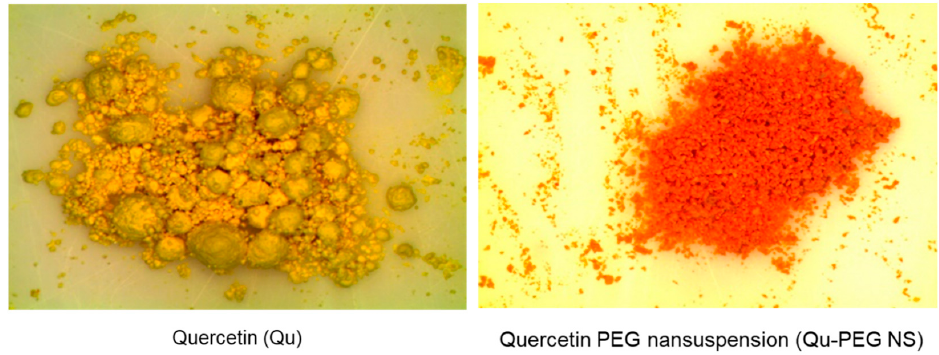
Figure 2. Stereomicroscopy photographs of quercetin (Qu) and quercetin with PEG nanosuspension 1 (Qu-PEG NS). Table 1. The composition ratio of nanosuspension formulation. Formulation Ratio (Quercetin: PEG8000) Qu-PEG NS1